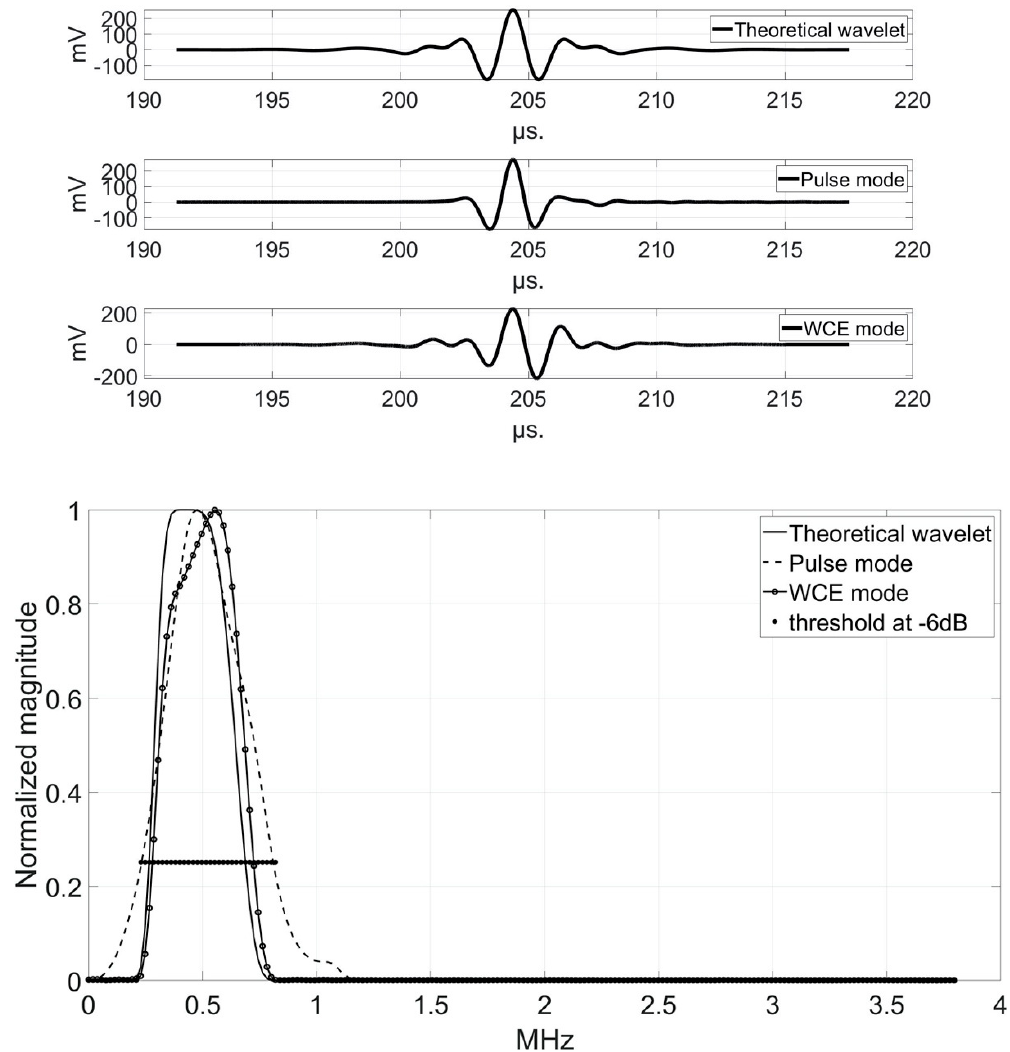
Figure 6. Comparison of the temporal representations ( top ) and frequency spectra ( bottom ) of the theoretical analyzing wavelet (solid line), the transmitted pulse signal (dashed line), and the pseudo-wavelet (dotted line) for the 500 kHz- transducer.